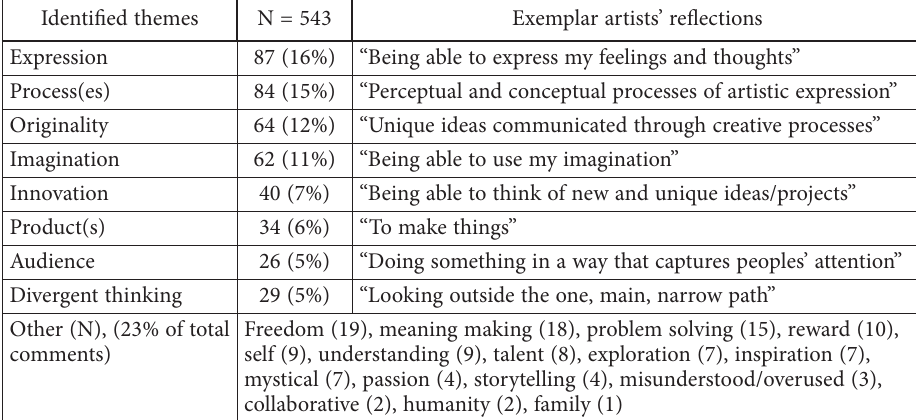
Table 2. Thematic analysis of participants’ understandings of the creativity concept (source: created by